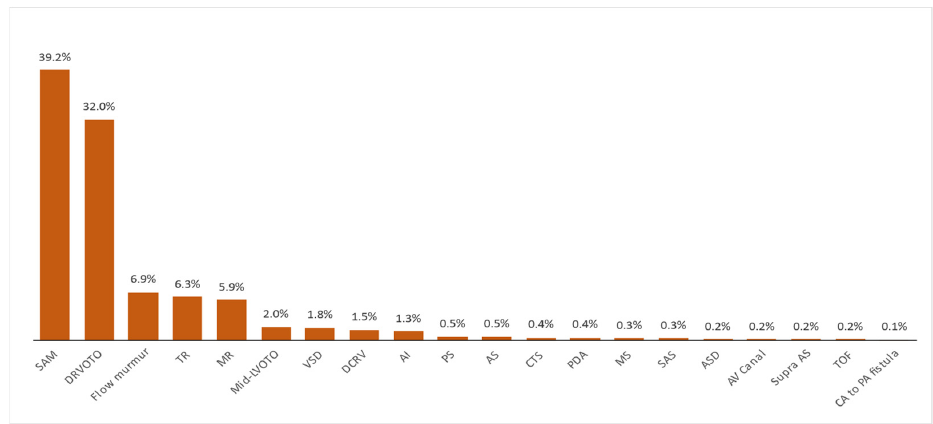
Figure 2. Histogram showing the frequency of various origins of blood flow turbulence responsible for the presence of an audible heart murmur in a population of 856 cats. SAM: systolic anterior